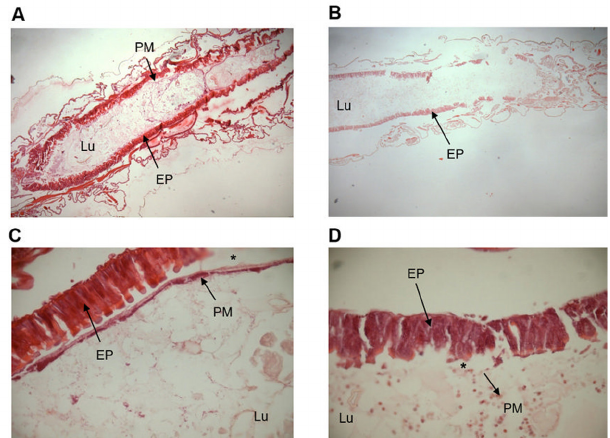
Figure 6. Photomicrographs of fifth-instar larvae of Spodoptera frugiperda . ( A ) Midgut of control larvae, 10 × . ( B ) Midgut of larvae fed on a 0.5% talisin diet, 10 × ( C ) Midgut epithelium of control larvae, 40 × ( D ) Midgut epithelium of larvae fed on a 0.5% talisin diet, 40 × . Lu, Lumen; EP, Epithelium; PM, Peritrophic Membrane; (*) Di ff erence between the ectoperitrophic